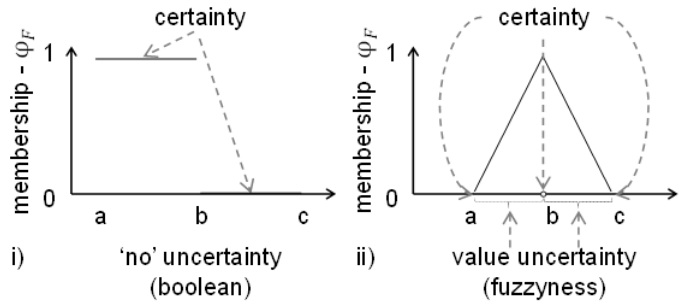
Figure 1. Regions of certainty, with membership equal to 1 or 0, and uncertainty, with transition between conditions of pertinence and non- pertinence: ( i ) classical (type-0 fuzzy set), and ( ii ) type-1 fuzzy set. Source: Bressane et al.